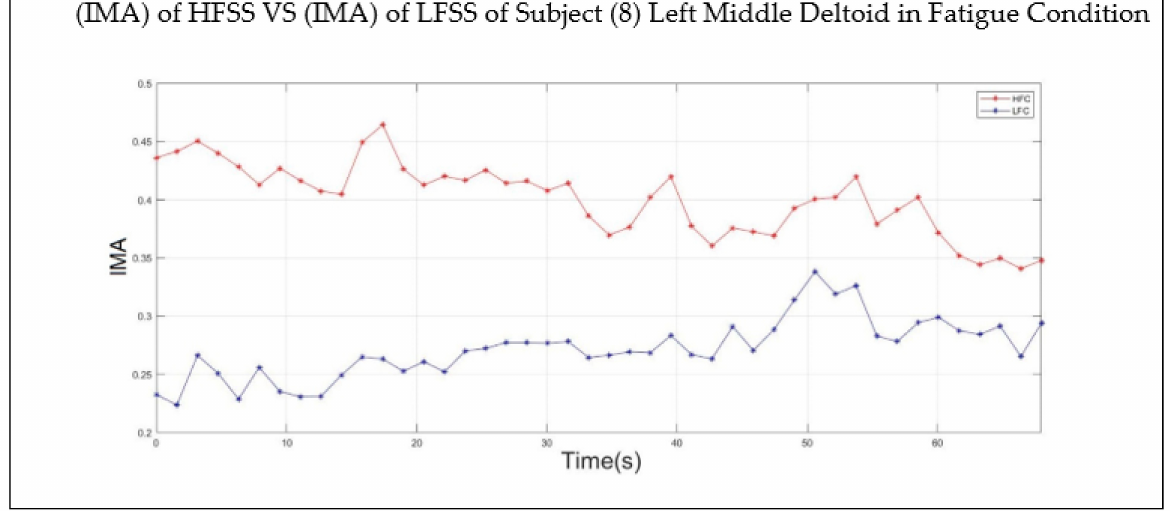
Figure 8. Behavior of IMA of the HFSS (red line) and LFSS (blue line) of the left middle deltoid muscle of subject 8 in fatigue